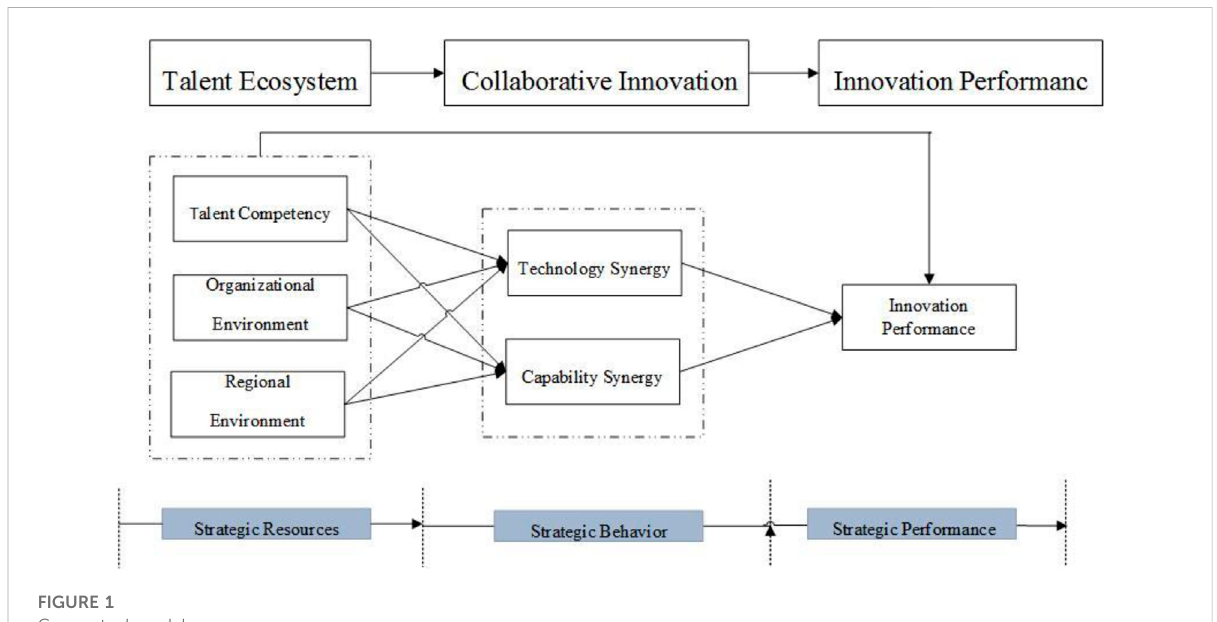
FIGURE 1 Conceptual